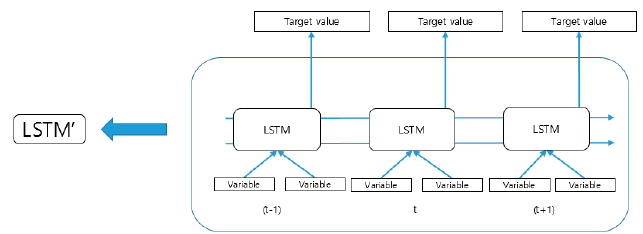
Figure 25. LSTM algorithm for selecting all predictions of the past and the present.